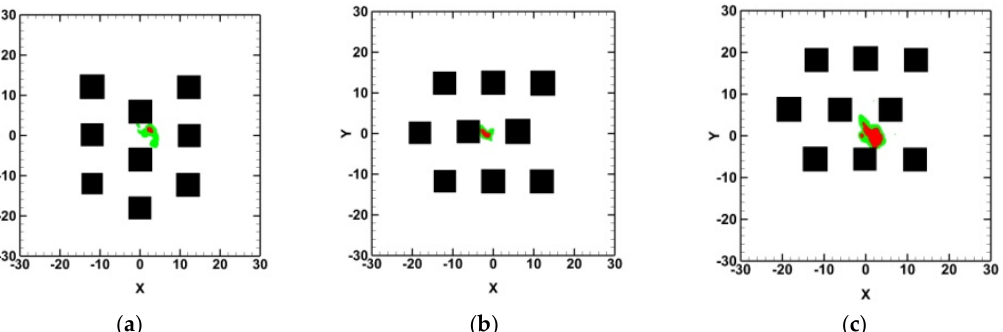
Figure 12. The LC1 and IDLH zones for a horizontal plane at Z = 1 m above the ground for ( a ) Case 1; ( b ) Case 2; ( c ) Case 3, after 200 s of the fire accident.